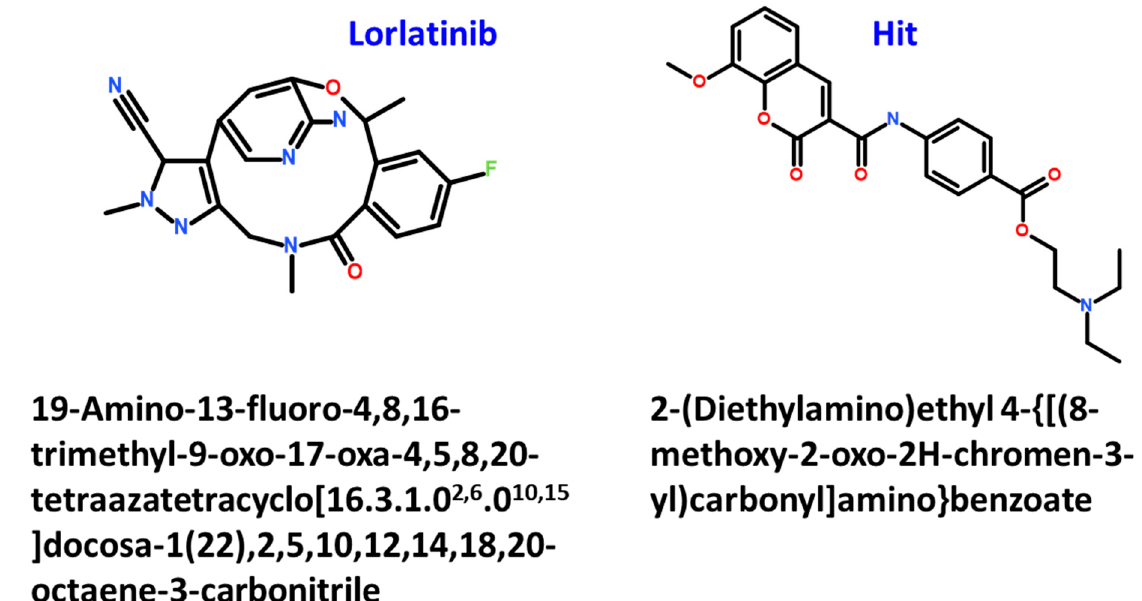
Figure 7. The 2D structures of lorlatinib and Hit flavonoid compound of ROS-1 tyrosine kinase.